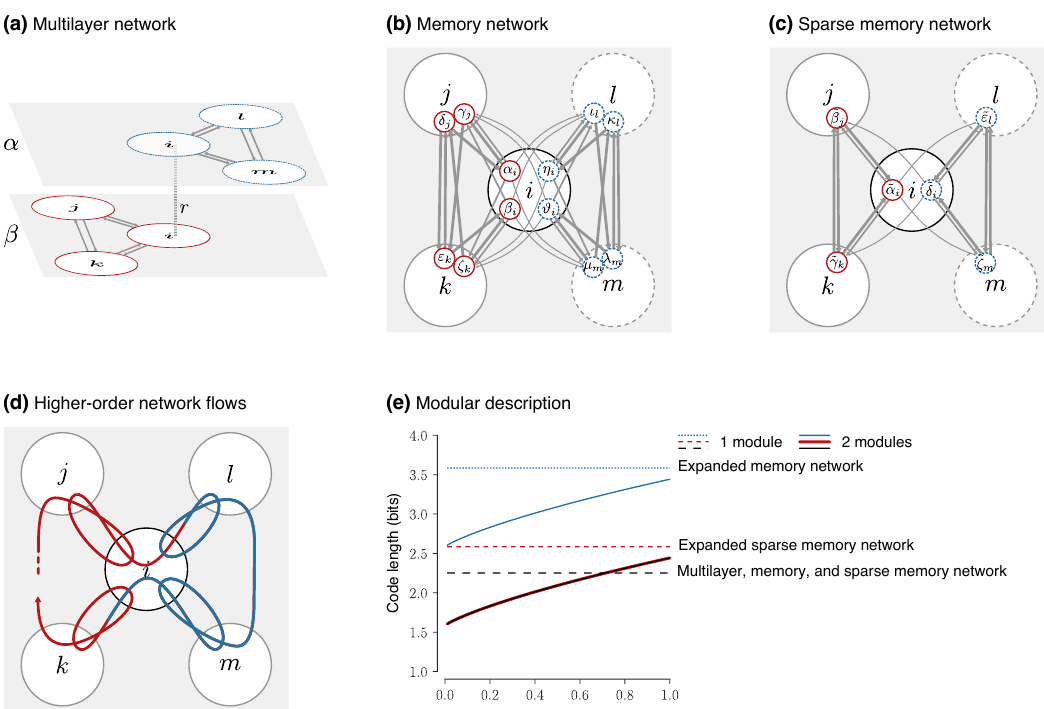
Figure 4. Mapping higher-order network flows. ( a ) A clustered multilayer network with relax rate r ; ( b ) The same network flows in a clustered second-order memory network; ( c ) The same network flows in a clustered sparse memory network; ( d ) Sample of corresponding higher-order flow pathways; ( e ) Code length as a function of the transition rate for all representations as well as extended networks with virtual physical